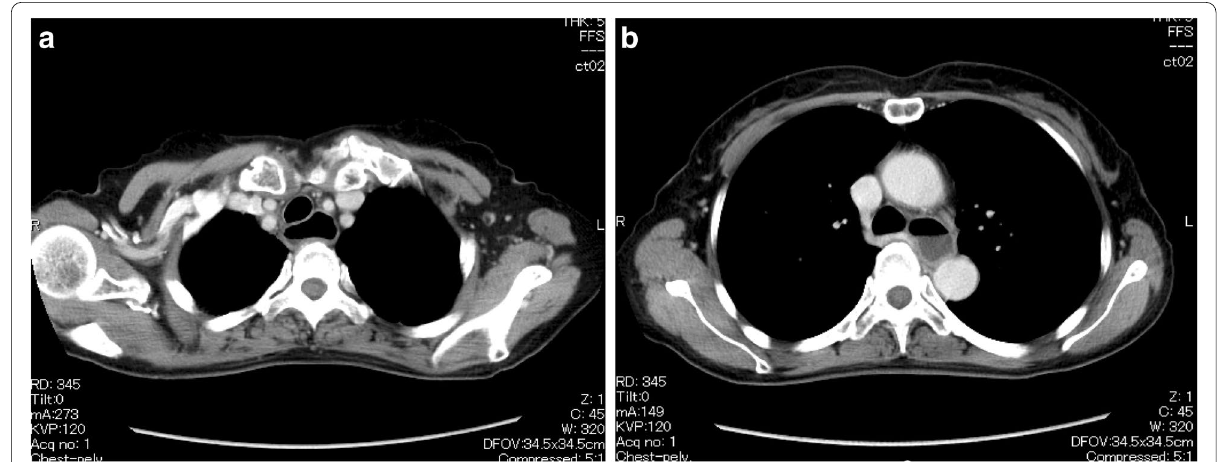
Fig. 1 Preoperative thoracic computed tomography showing fluid retention in the dilated esophagus. a Upper thoracic region. b Middle thoracic